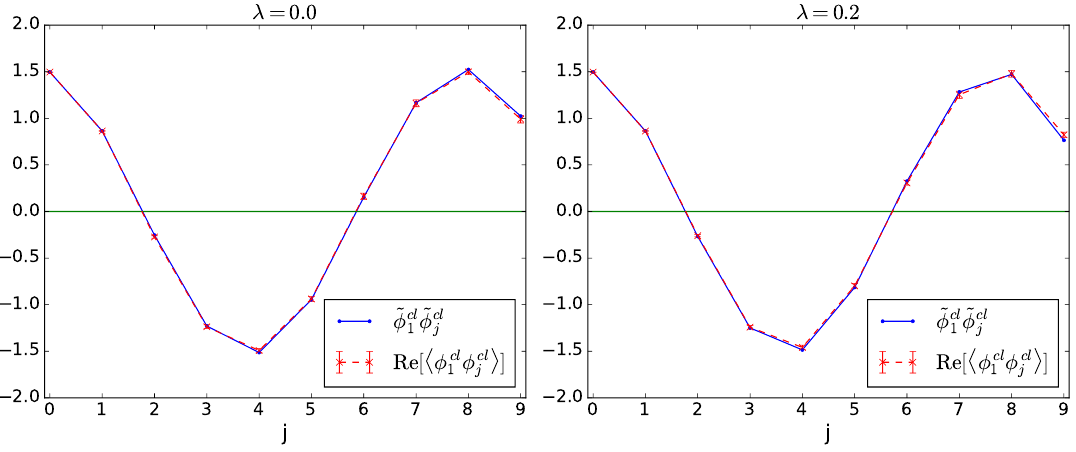
Figure 5 . The classical correlator for a single initial condition, and the corresponding quantum averaged correlator. For (cid:21) = 0 : 0 (left) and 0 : 2